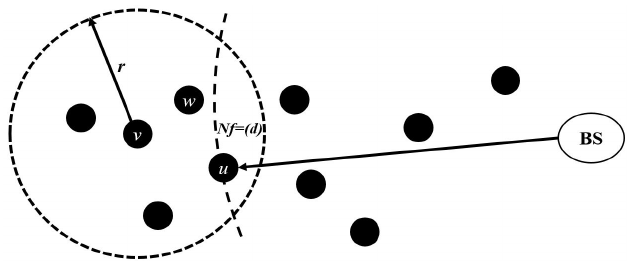
Figure 3. Shortest path